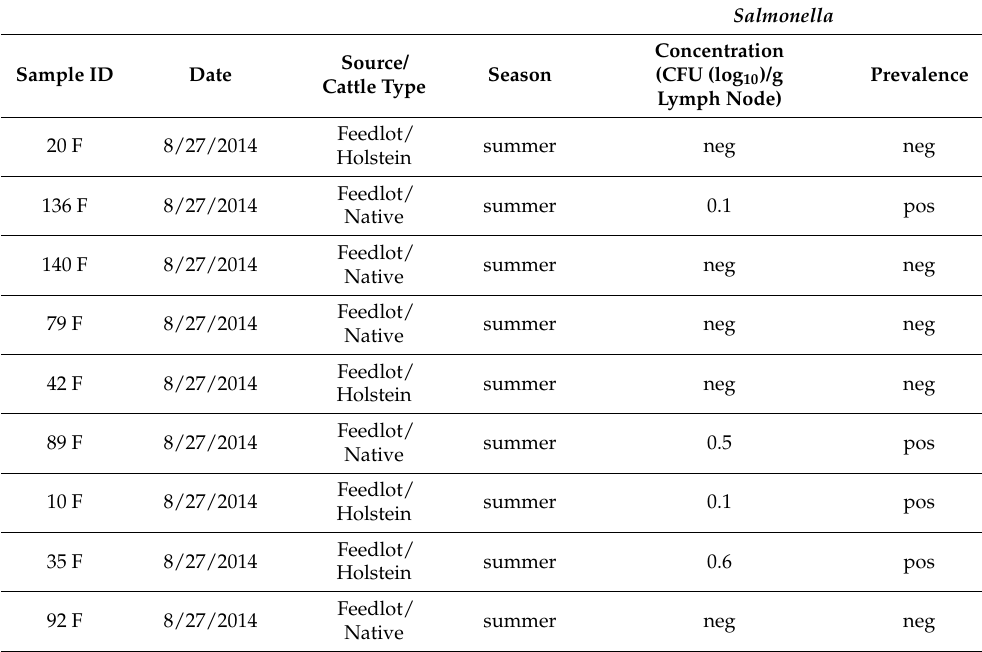
Table 1. Details of cattle positive or negative for Salmonella in the sub-iliac lymph node collected for kinome